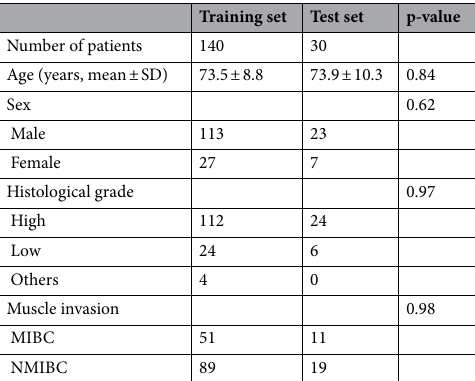
Training set Test set